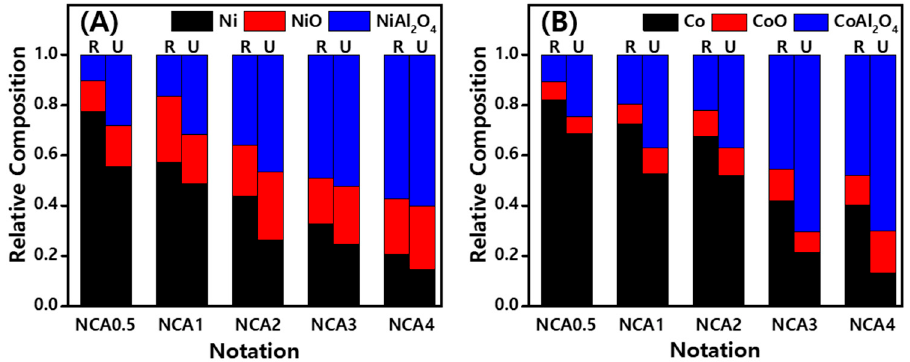
Figure 5. Relative crystalline compositions of the ( A ) reduced and ( B ) used NCA catalysts derived from the linear combination fitting (LCF) by comparing them with reference materials.